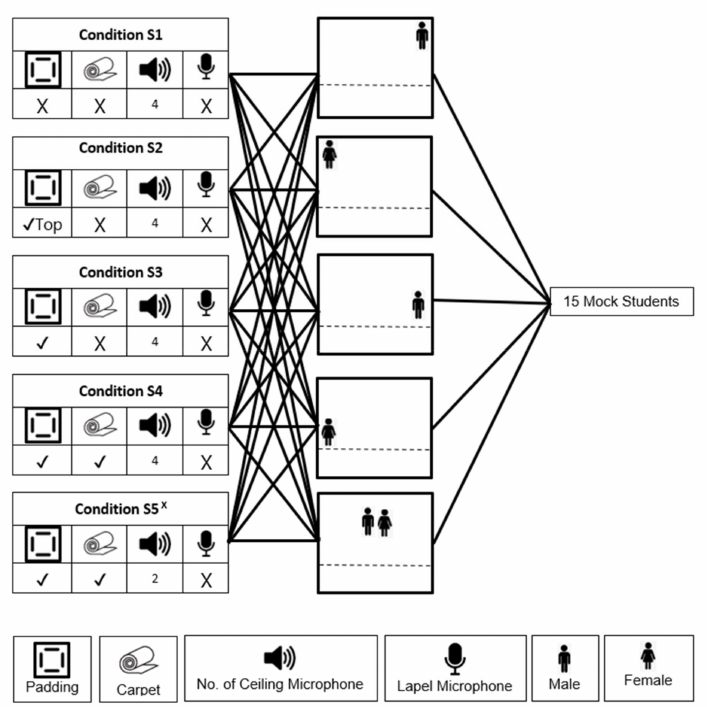
Figure 4. Students’ Interaction Conditions and Tests Procedural Flow